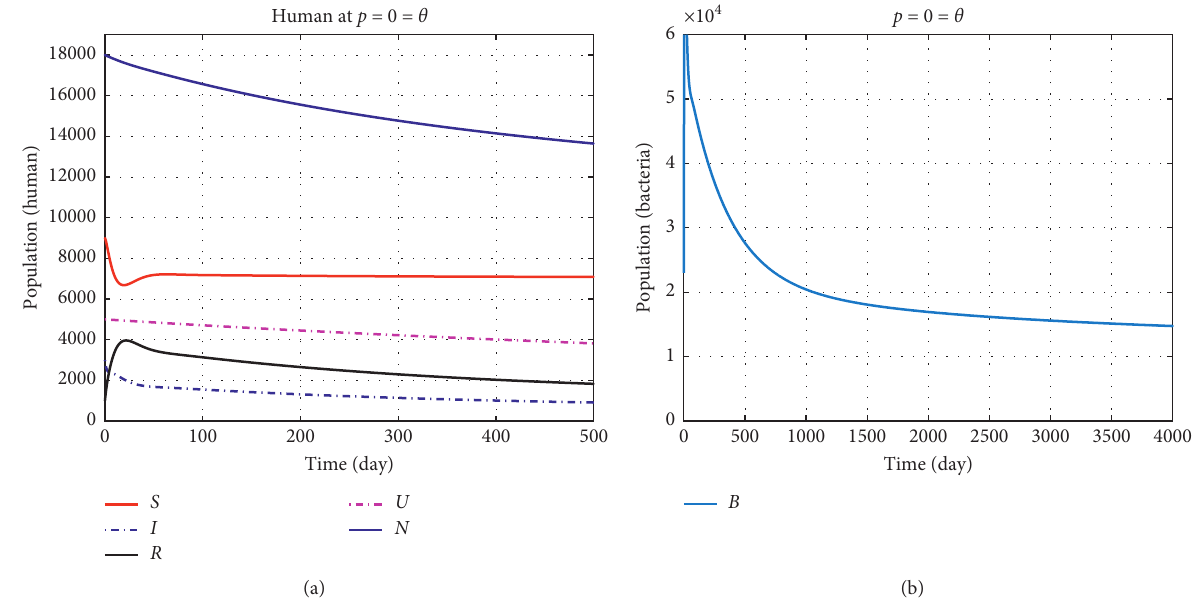
Figure 6: Time series solution of individual (a) and bacteria (b) cohorts when p � θ � 0. The diseases do not die out ( R